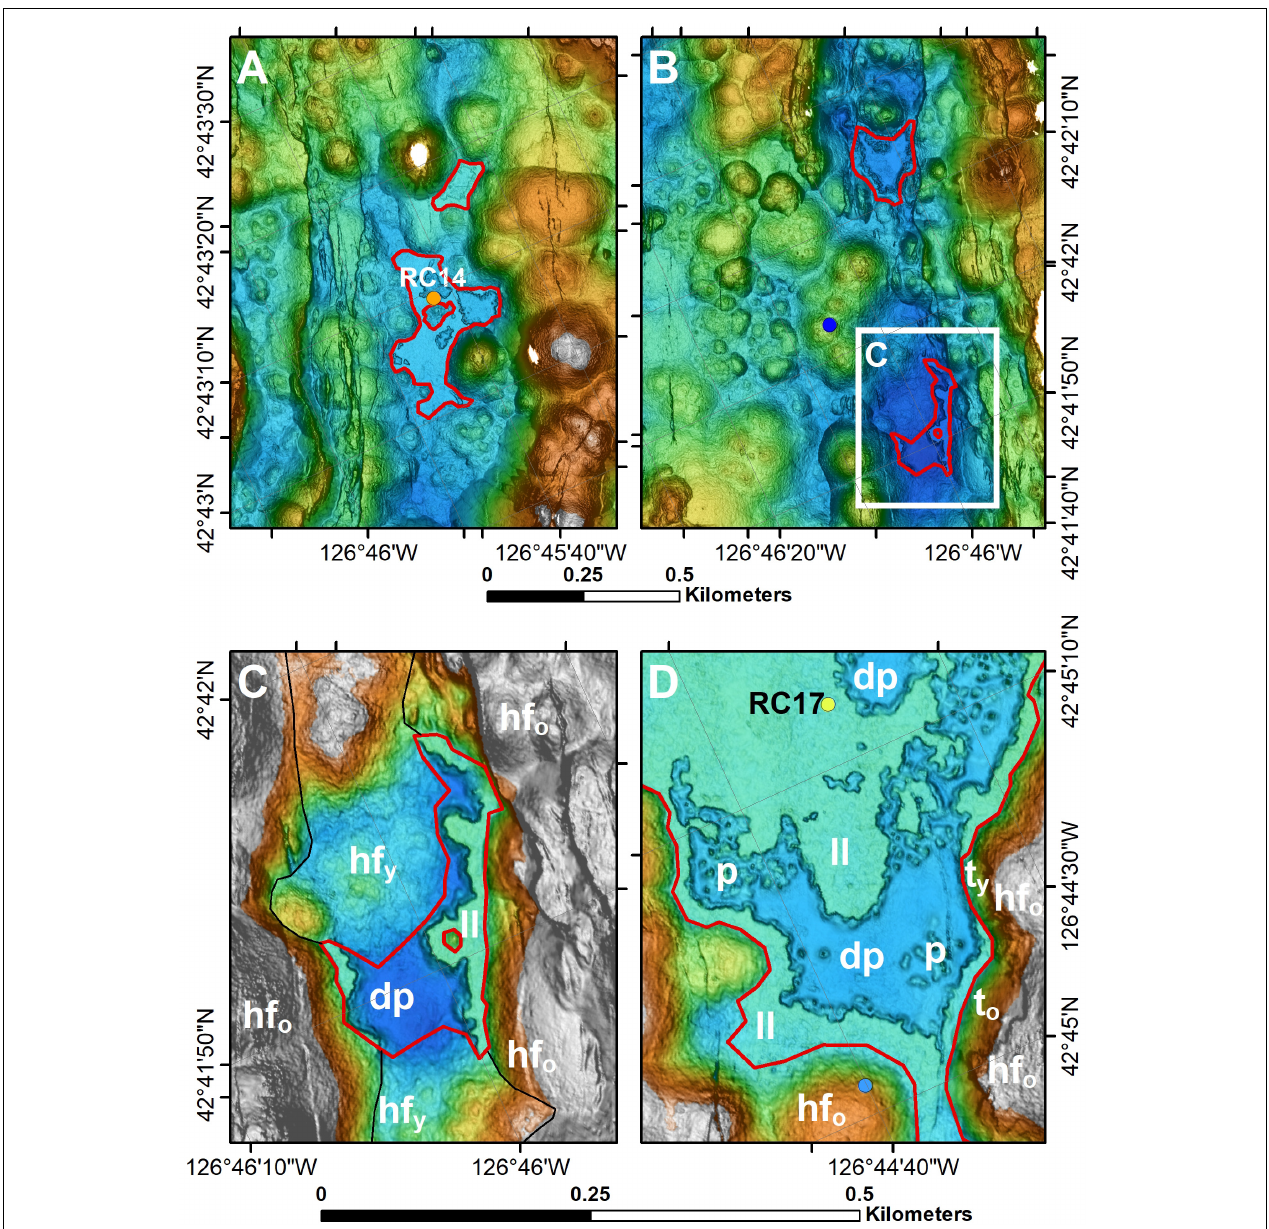
FIGURE 13 | (A) The central two small flows ponded between older hummocky flows and are of unknown age. The sampled (RC14) southern one is chemically and mineralogically distinct from the northern flows in Figure 12B . (B) The southern flows also ponded between older hummocky flows. The location of the close-up view of this flow remnant shown in Figure 13C is indicated by the white box. Color ramp for A and B is blue = − 3170 m and orange = − 2970 m. (C) Small remnants of a ponded channelized flow that filled in between older hummocky flows ( hf o ) to east and west. The drained pond ( dp ) is partially filled in by younger hummocky flows ( hf y ) from both the north and south. The margins of the pond record the original lake level ( ll ). Color ramp is blue = –3165 m to orange = –3130 m, white is shallower than –3130 m. (D) Close-up view of the largest ponded channelized flow, showing the drained pond ( dp ) with lava pillars ( p ) near the margins, and the original lake level ( ll ) that formed as a levee adjacent to older hummocky flows ( hf o ). Talus emplaced prior to the pond on the flank of a hummocky flow ( hf o ) to the east is labeled t o , whereas talus that fell later and covers a portion of the lava pond levee is labeled t y . Color ramp of blue = –3080 m to orange = –3040m. Maps A to D are all rotated counterclockwise 23 ◦